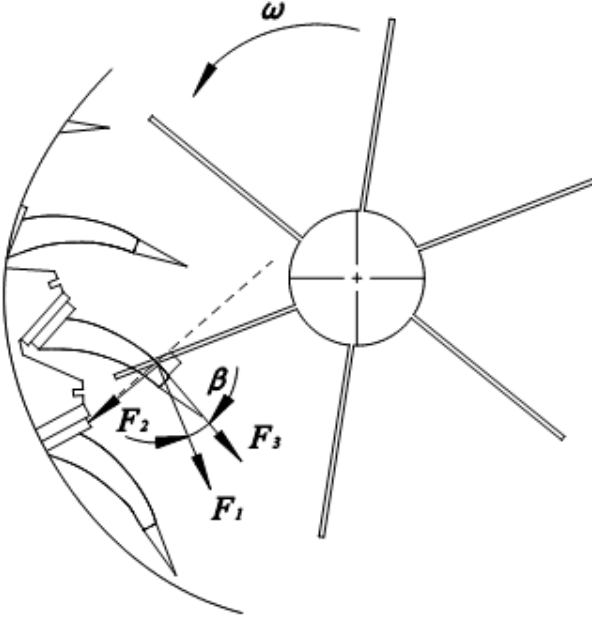
Figure 4. Schematic diagram of the force of the blade on the residual film.